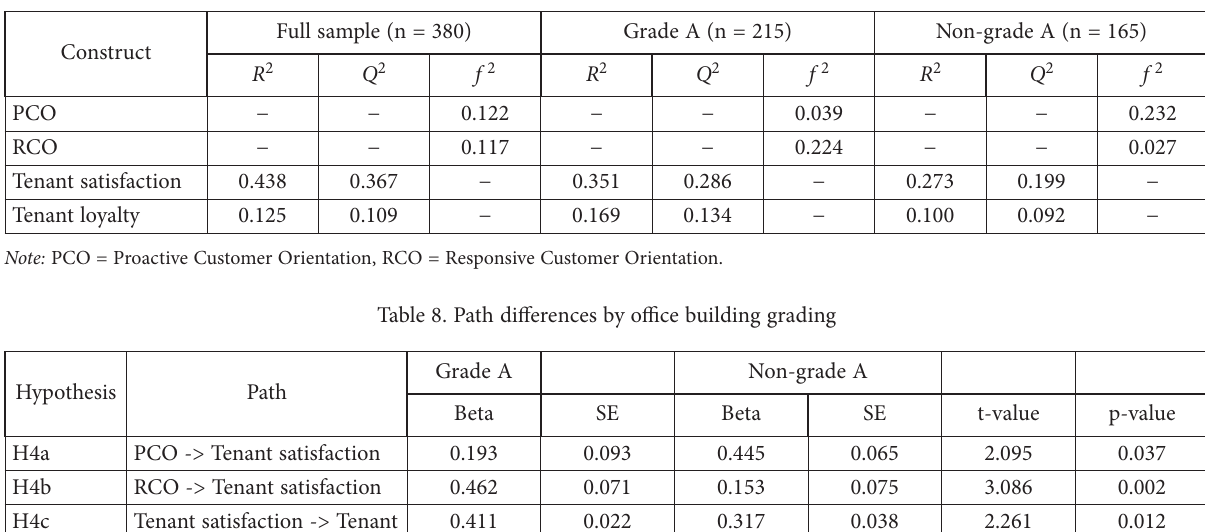
Table 7. Result of R 2 , Q 2 and f 2